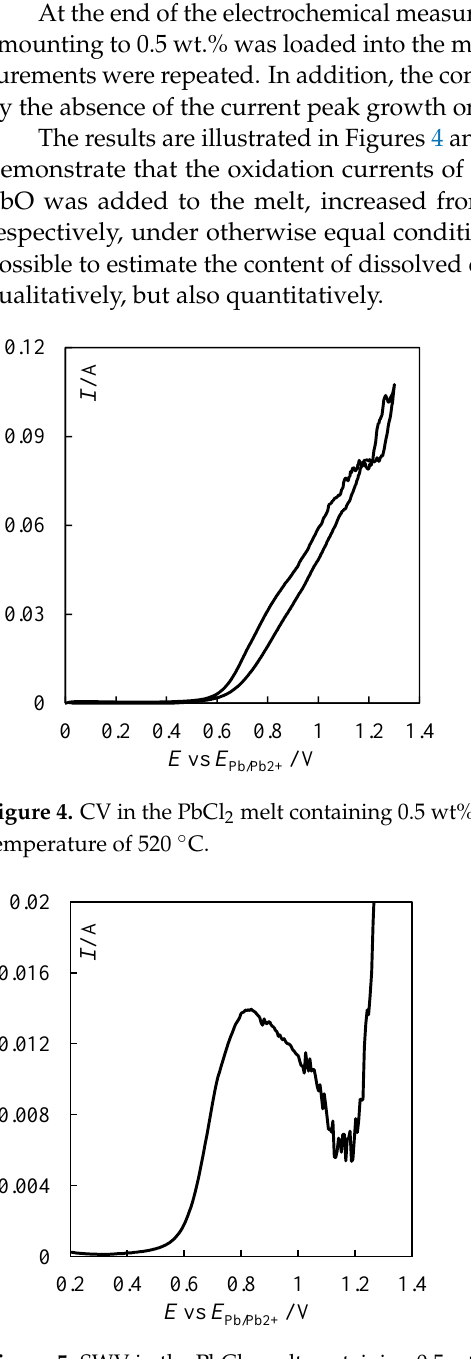
Figure 5. SWV in the PbCl 2 melt containing 0.5 wt% of PbO at a potential reverse frequency of 25 Hz, amplitude of 20 mV, potential sweep rate of 0.1 V s −1 and a temperature of 520 °C.